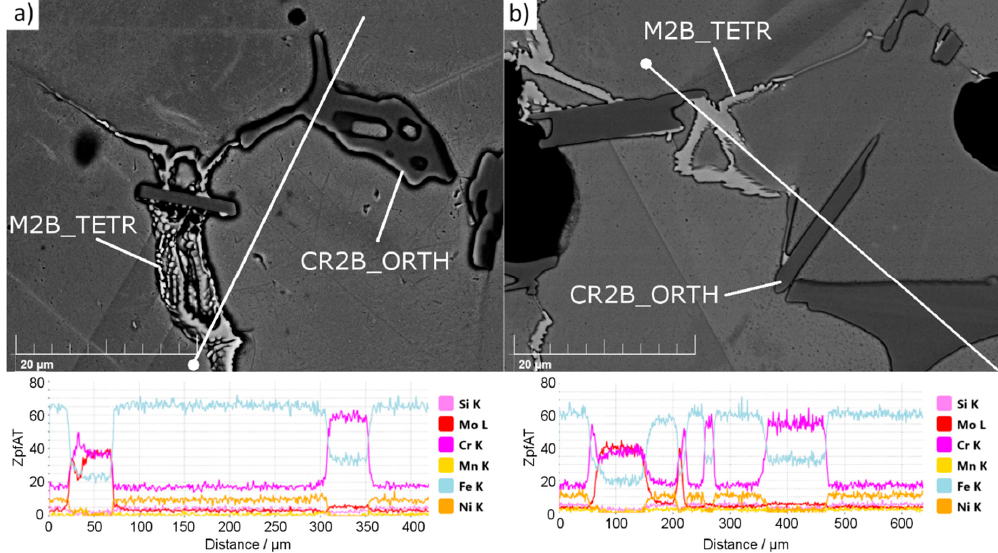
Figure 2. Scanning Electron Microscope Energy-Dispersive X-ray spectroscopy ( SEM EDX) linear scans of borides found in a ) sample 4-0 and b ) sample 4-8. White dots mark the starting points of the